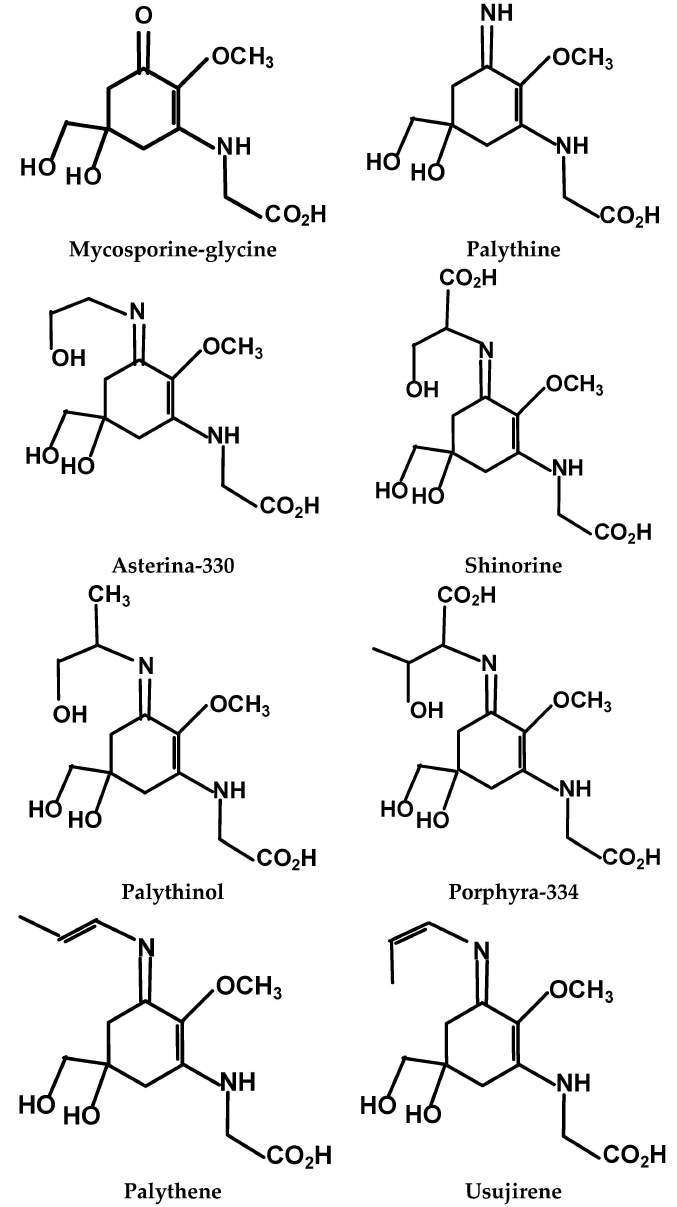
Figure 1. The main mycosporine-like amino acids (MAAs) identified in